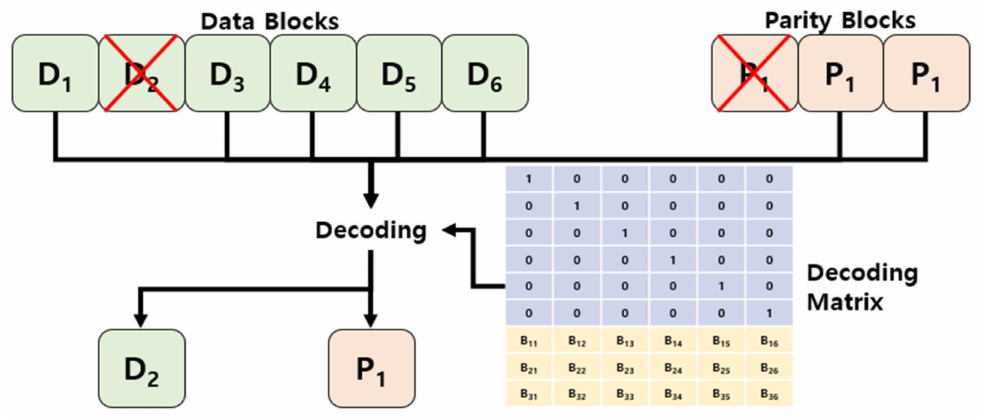
Figure 2. Decoding process of erasure coding.